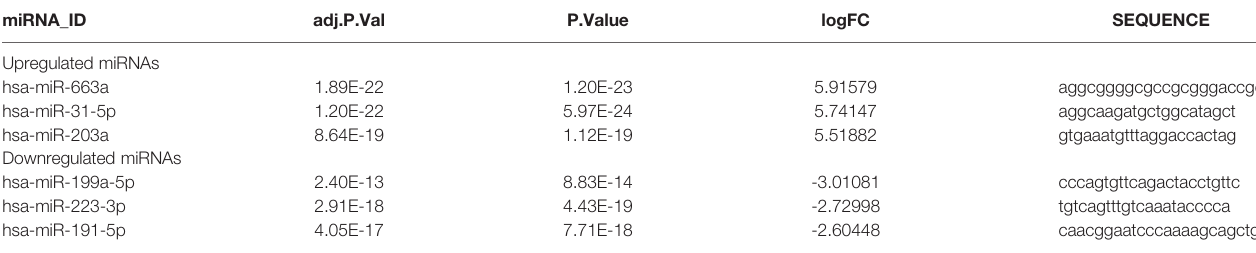
TABLE 1 | The top three most miRNAs and top three most downregulated miRNAs between osteosarcoma and normal plasma samples. miRNA_ID adj.P.Val